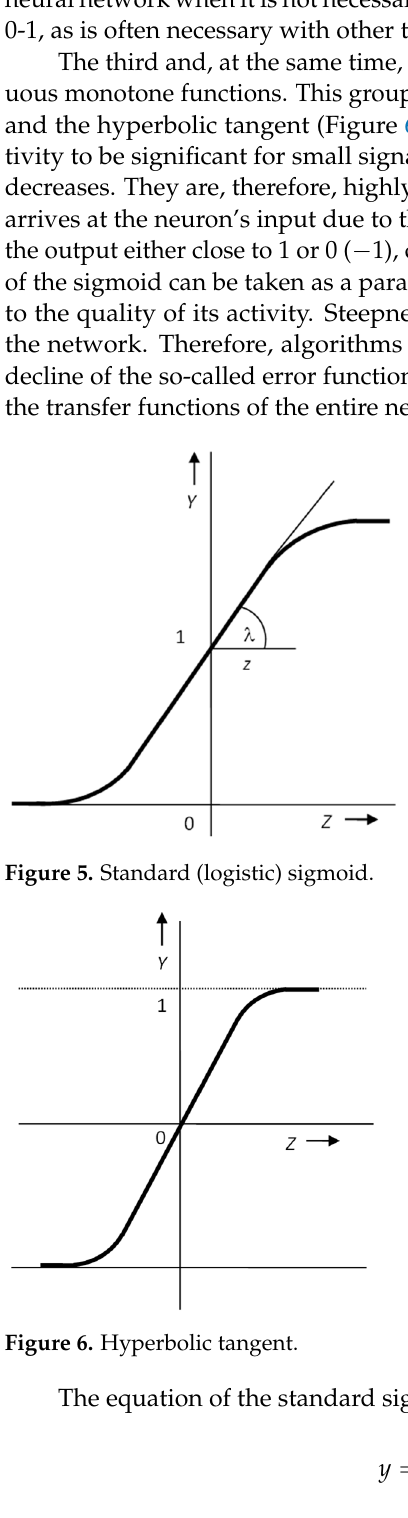
Figure 4. Linear activation function.